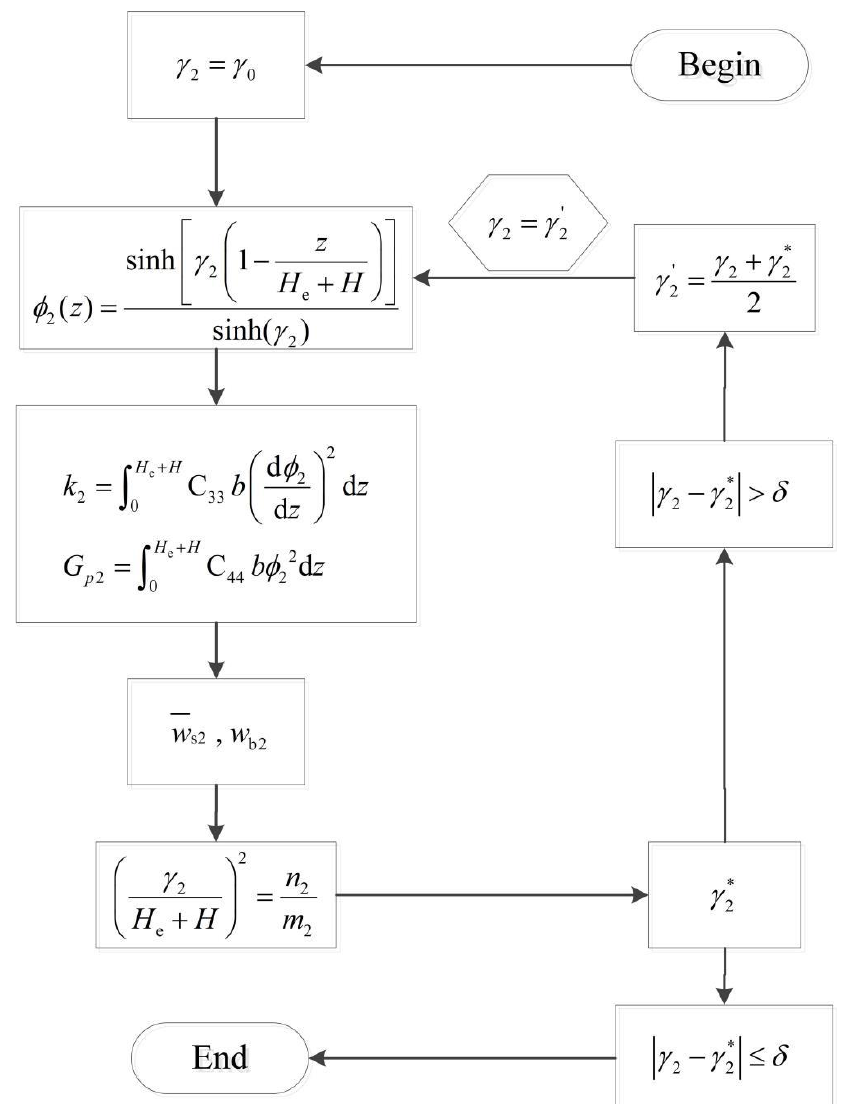
Figure 4. Iterative flowchart of attenuation parameters for transversely isotropic foundations.